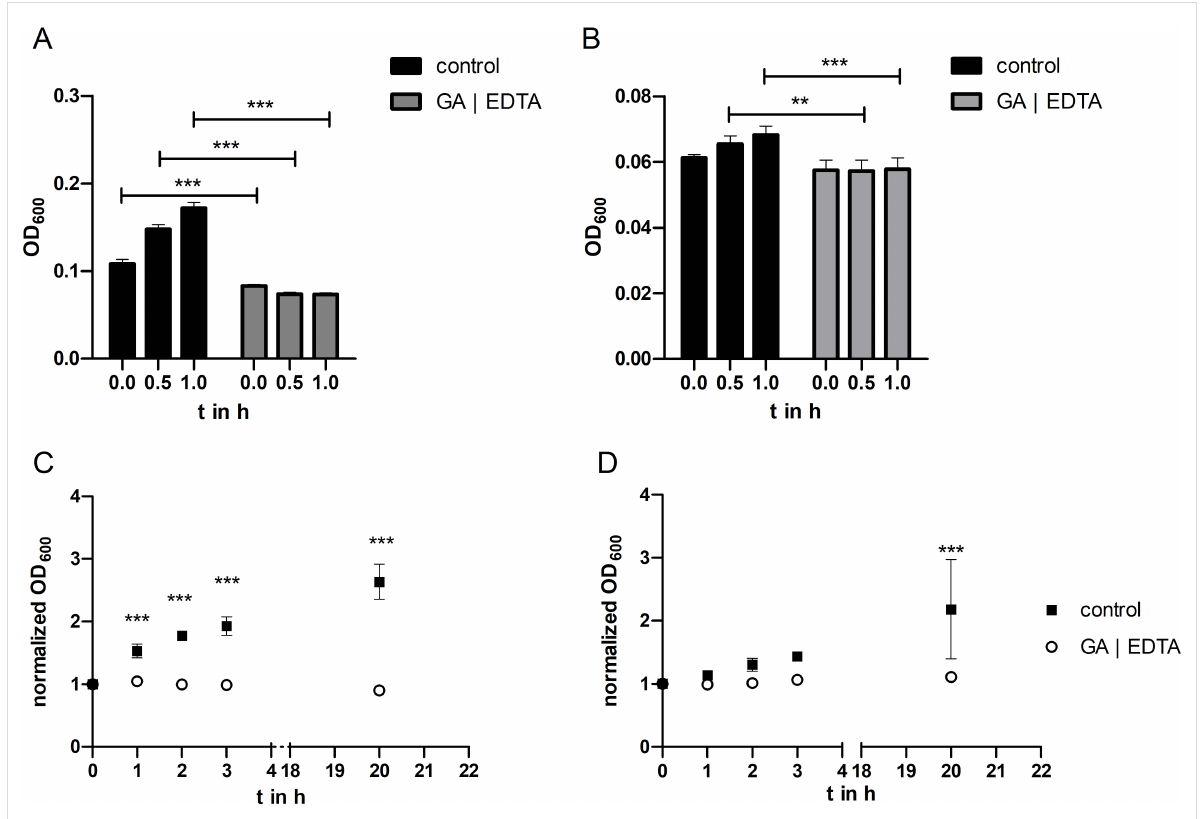
Figure 5: Effect of a combination of glutaraldehyde and EDTA on E. coli and S. epidermidis . E. coli (A) and S. epidermidis (B) cells were grown in Mueller–Hinton II Bouillon (“control”) and Mueller–Hinton II Bouillon supplemented with 0.02% glutaraldehyde and 0.2 M EDTA (“GA | EDTA”) for one hour at room temperature. SD for GA | EDTA in (A) is 0.005. (C, D) Cells grown as described in (A) and (B) were subsequently incubated at 37 °C for 20 h. Error bars are SD ( n = 4 biological replicates). Statistical analysis was performed by a two-way ANOVA with Bonferroni’s multiple comparison test; ** corresponds to p < 0.01; *** corresponds to p <